Question: According to this chart, does the measure grow or shrink?
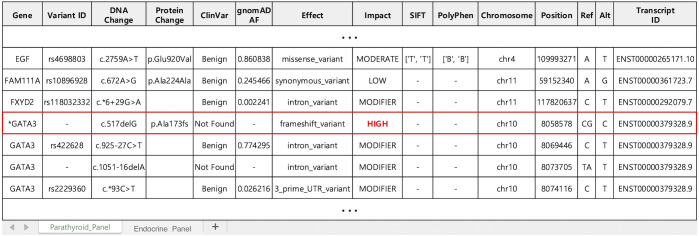
Answer: increasing